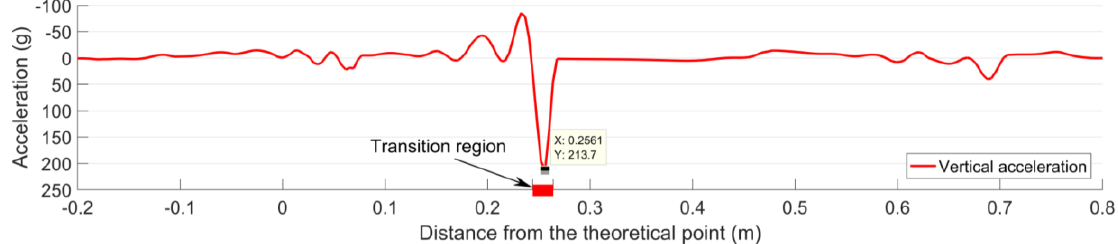
Figure 26. Simulation results of the 1:9 trailing crossing with rail wear and deformation taken into account.